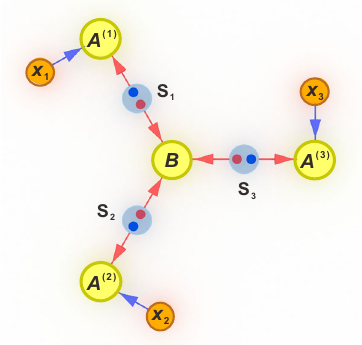
Fig. 1 | The three-branch star network. Bipartite physical systems, generated at the sources S i , are distributed to the yellow parties, which perform measurements in the systems received. The branch parties have a choice of measurement to perform in the systems received, illustrated with the circles denoted by x i